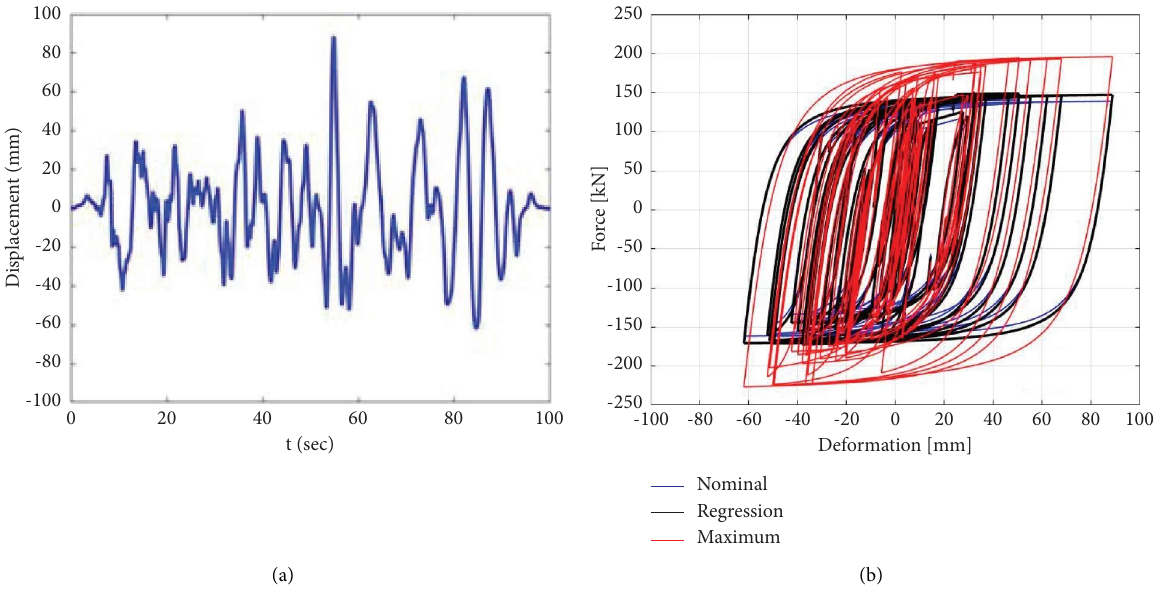
Figure 7: ID0169: applied displacements (a) and hysteresis curves